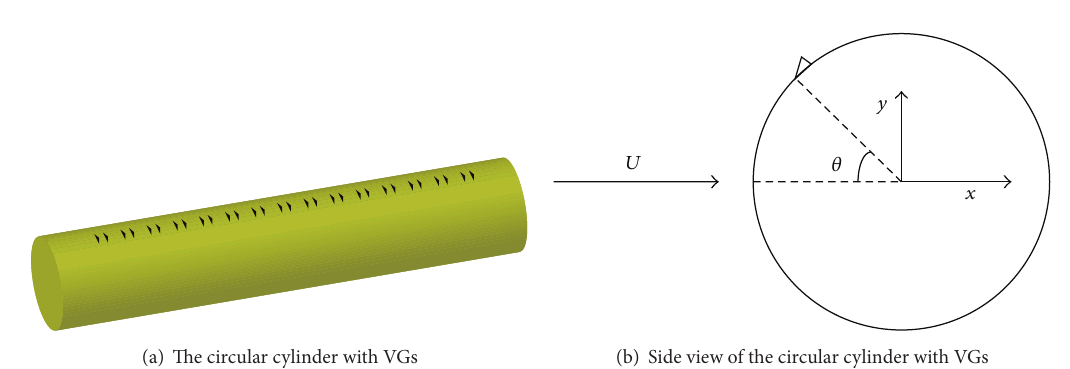
Figure 4: Experiment facility.